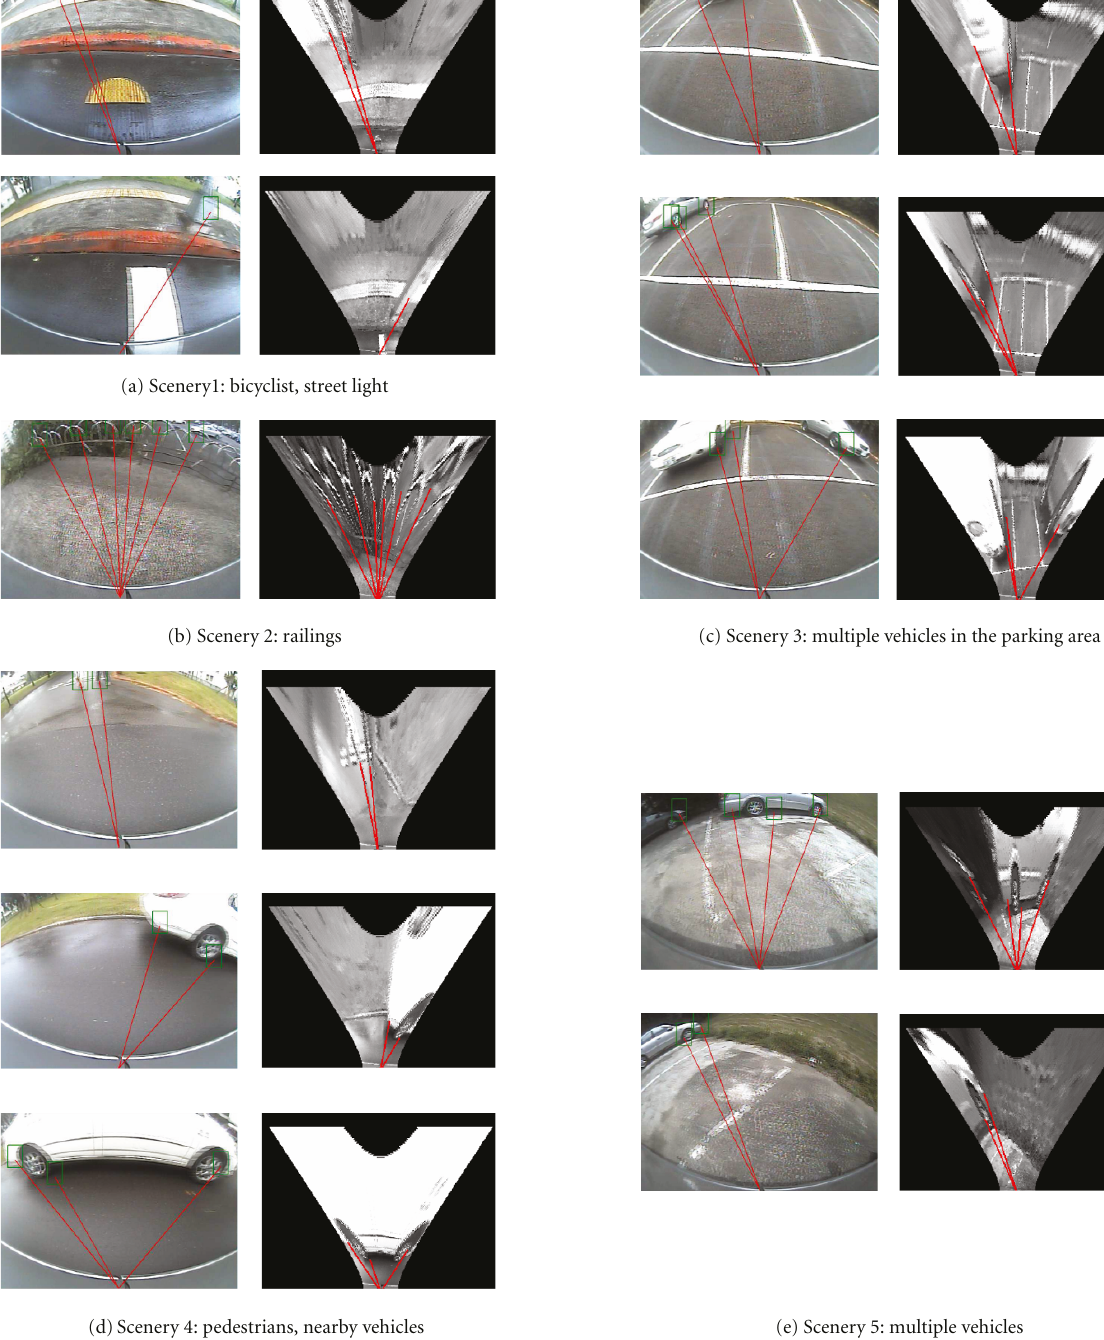
Figure 22: The experimental results of FLIPM and obstacle detection in di ff erent scenes (a) Scenery1: bicyclist, street light (b) Scenery 2: railings (c) Scenery 3: multiple vehicles in the parking area (d) Scenery 4: pedestrians, nearby vehicles (e) Scenery 5: multiple vehicles.